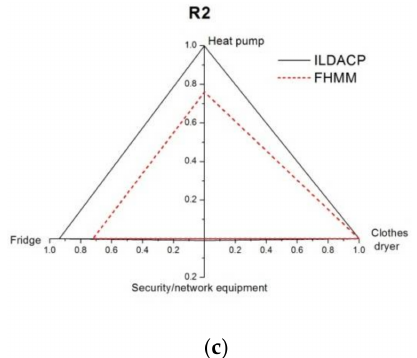
Figure 4. This is disaggregation accuracy metrics for our iterative load disaggregation approach based on appliance consumption pattern (ILDACP) and factorial hidden Markov model (FHMM) on four simultaneously operating appliances. From top: ( a ) F-score; ( b ) Power contribution error (PCE); and, ( c ) R2.